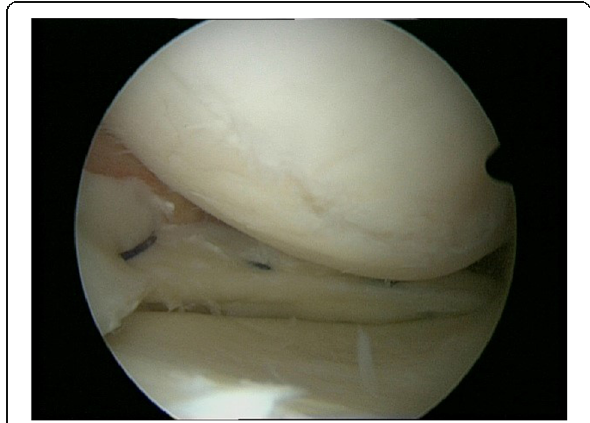
Fig. 2 Meniscus suture. Forty two years old woman, medial meniscus left knee: performed meniscus suture in the red-white area in an early degenerative knee joint. To support endogenous meniscal regeneration by vascular supply a trephination of the meniscus basis was performed prior to the suture. (published in (Zellner & Angele,